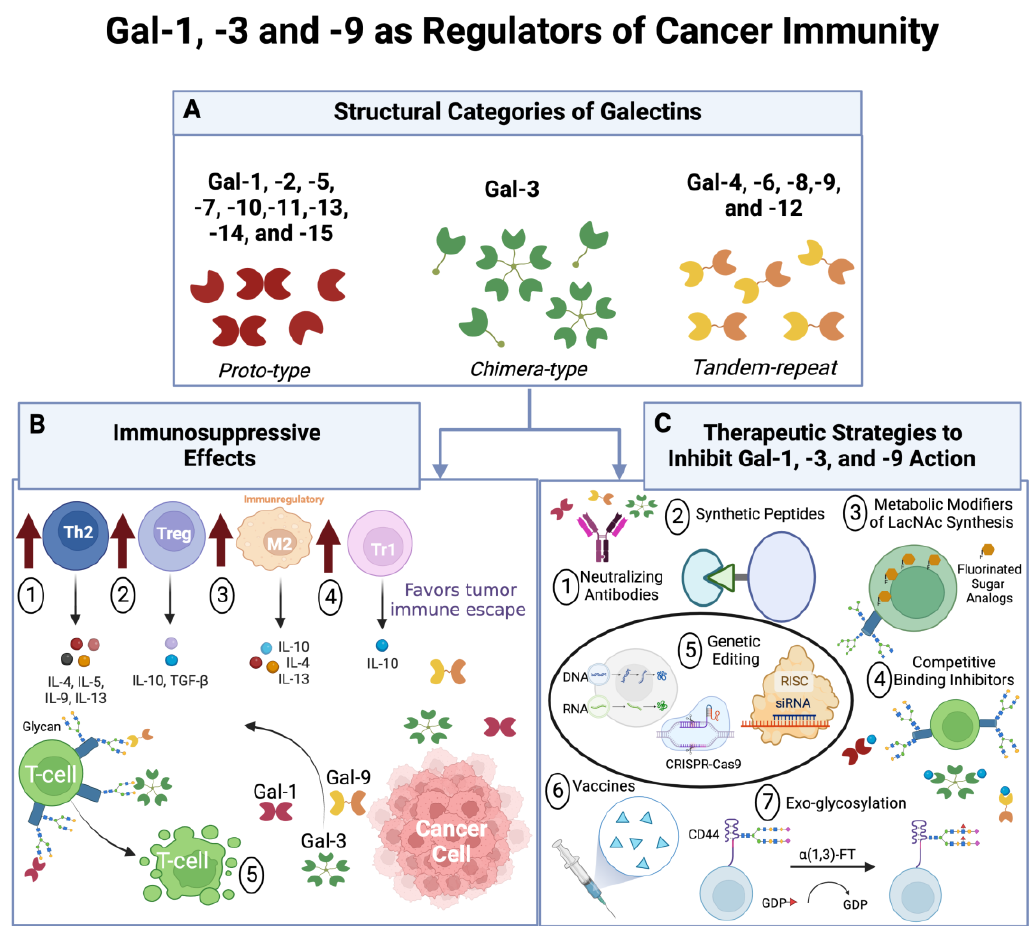
Figure 1. Gal-1, -3, and -9 as regulators of cancer immunity . ( A ) Structural categories of galectins: proto-type , containing one carbohydrate-recognition domain (CRD); chimera-type , with one CRD and an amino-terminal polypeptide tail region that forms pentamers in serum; and tandem repeat-type galectins, which contain two distinct CRDs. ( B ) Immunosuppressive effects: (1.) Th2 cell skewing; (2.) Treg cell expansion and suppressive activity; (3.) elevation in M2 macrophages; (4.) production of IL-10-producing T regulatory (Tr1) cells; and (5.) apoptosis of effector anti-tumor T cells. ( C ) Therapeutic strategies to inhibit Gal-1, -3, and -9 Action. Diagram was created using BioRender.com.